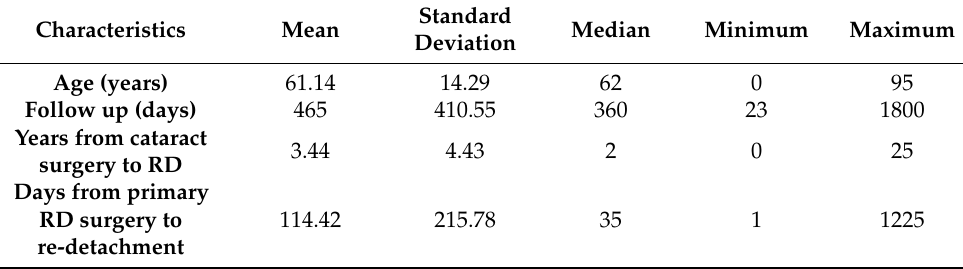
Table 3. Characteristics of the expressed as mean, standard deviation, median, minimum and maximum.